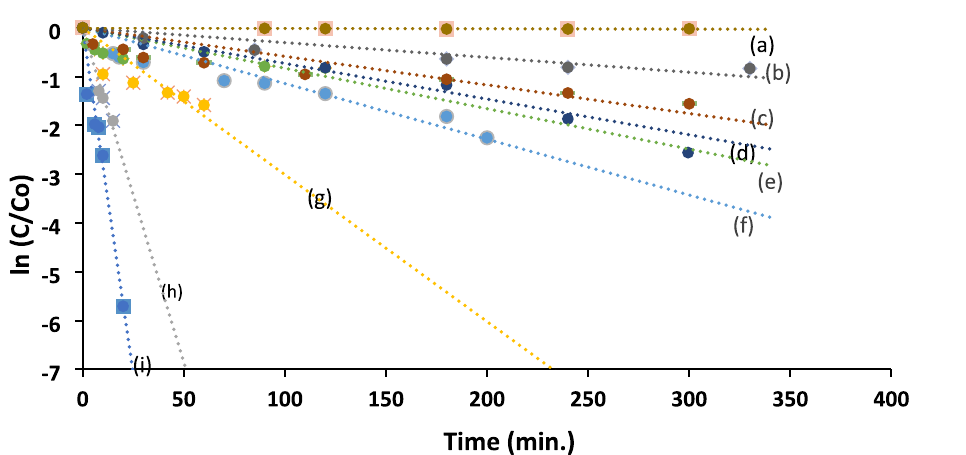
Figure 9. Photocatalytic degradation of 1.0 × 10 –4 M textile dye, under the influence of ( a ) UV irradiation only, ( b ) UV/0.5 g ZnO, ( c ) UV/0.5 g TiO 2 , ( d ) UV/0.5 g (ZnO–TiO 2 ), ( e ) UV/Ag (0.02 g/L), ( f ) UV/0.5 g (ZnO– TiO